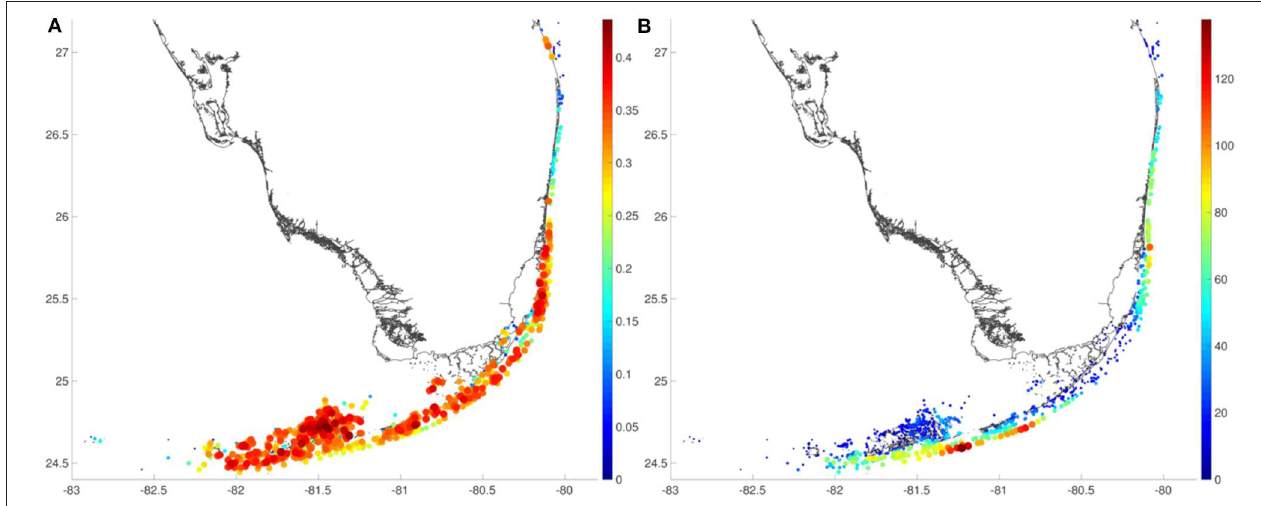
FIGURE 4 | (A) The proportion of larvae that settle and (B) the weighted connectivity length (WCL, in km) show that larvae originating from the outer shelf are transported further away but are also less likely to settle than larvae from the inner shelf. Inside dense reef matrices, larvae are more likely to settle and tend to reach reefs close to their source reef.